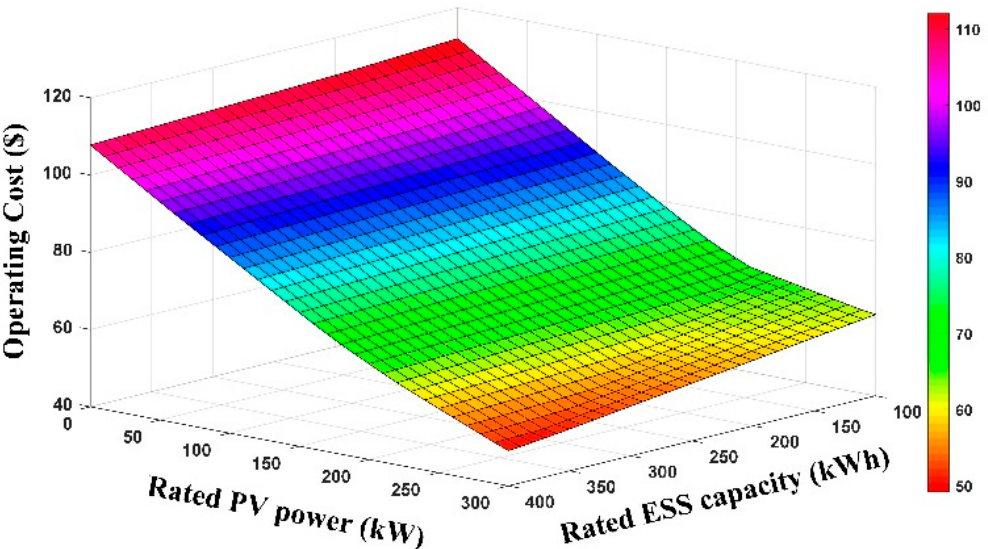
Figure 8. MG operating costs by changes in PV and battery capacities.